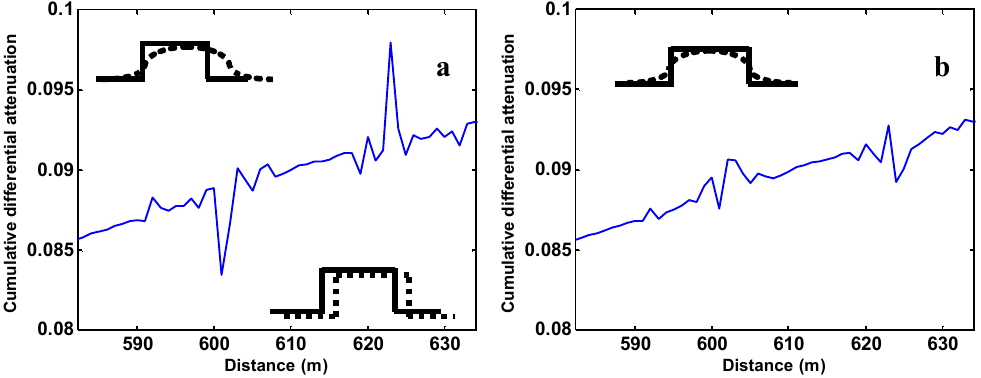
Figure 5. The schematic drawings show the nearby forward anti-Stokes (continuous line) and the shifted and more dispersed far reverse anti-Stokes (dotted line)